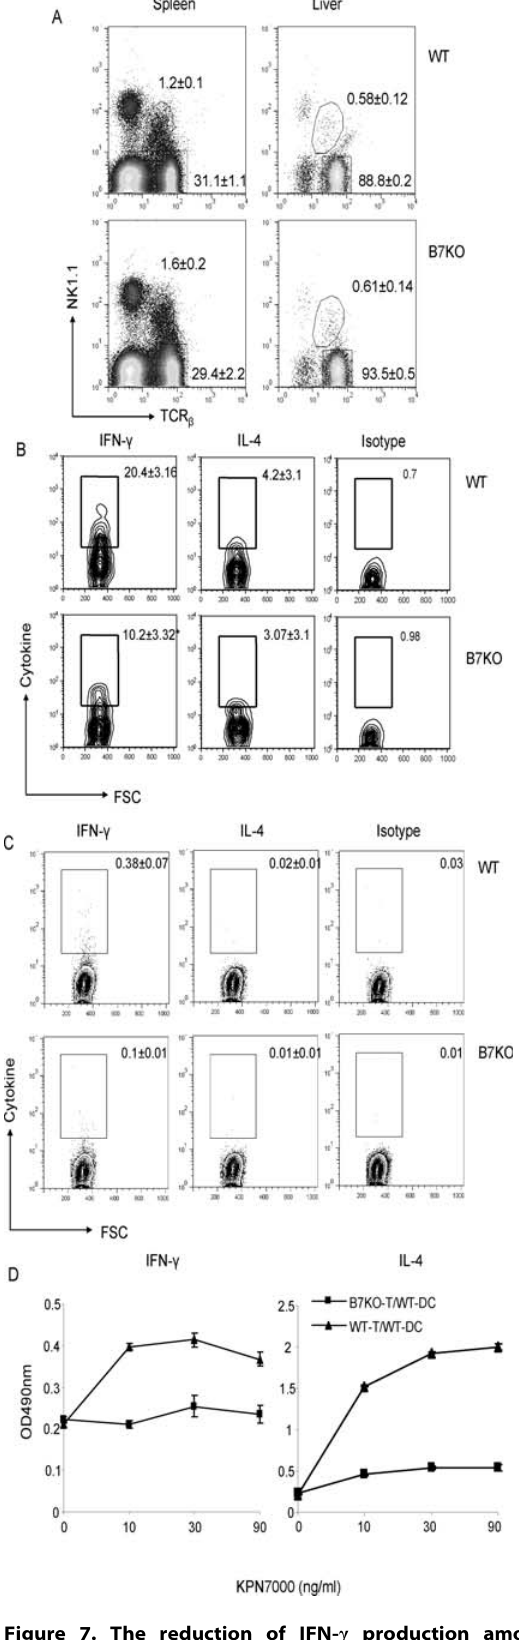
Figure 7. The reduction of IFN- c production among TCR b + NK1.1 + cells isolated from the liver of B7-1/2 deficient